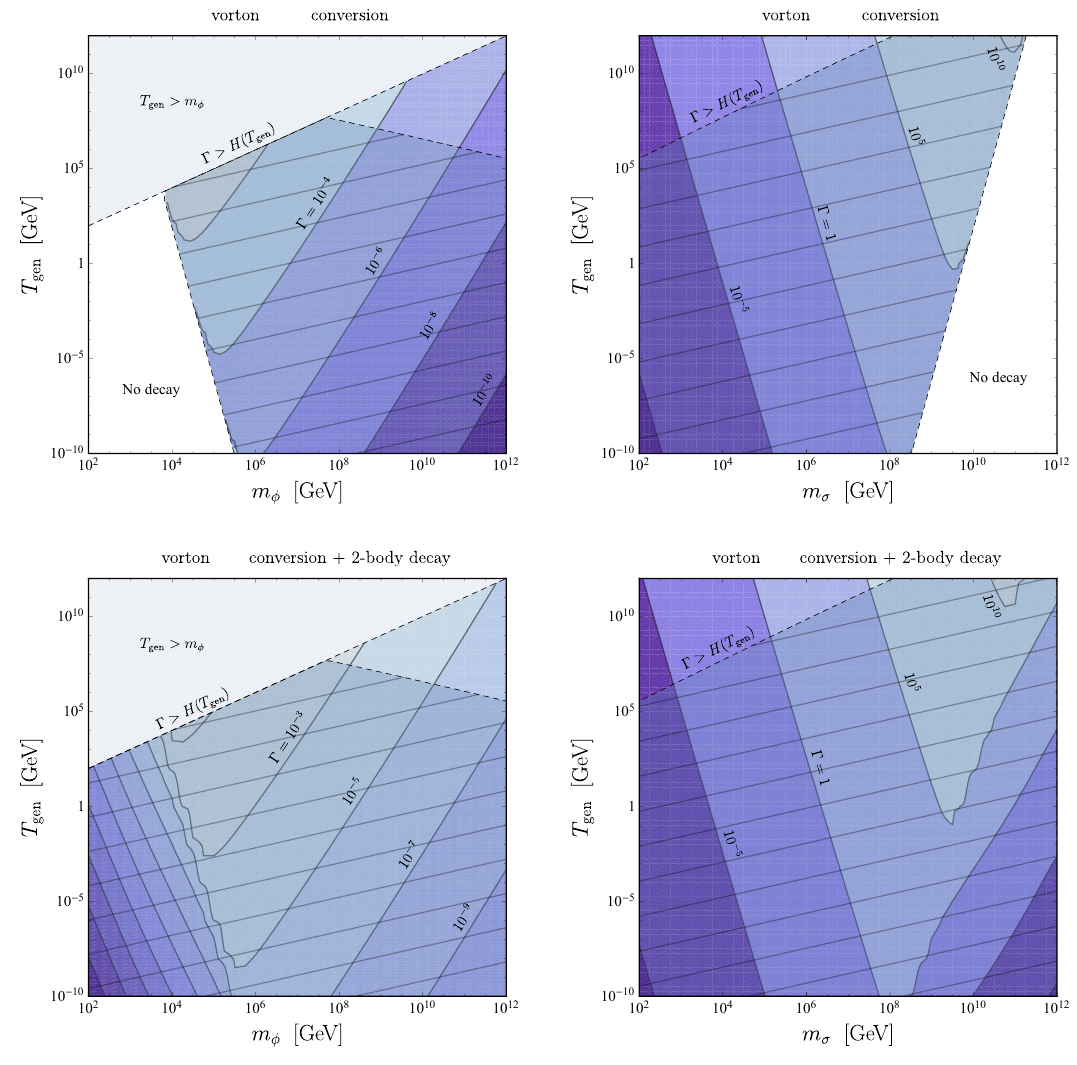
Figure 14 . The values of Γ in GeV unit for classically stable vortons produced at the temperature T = T gen are shown in the ( m φ , T gen ) -plane ( m σ = 10 2 GeV ) and in the ( m σ , T gen ) -plane ( m φ = 10 12 GeV ). The decay is assumed to be caused by the vorton curvature via the conversion (top panels) and the conversion and two-body decay (bottom panels). The white regions with “No decay” corresponds to the region in which the conversion process is kinematically forbidden.